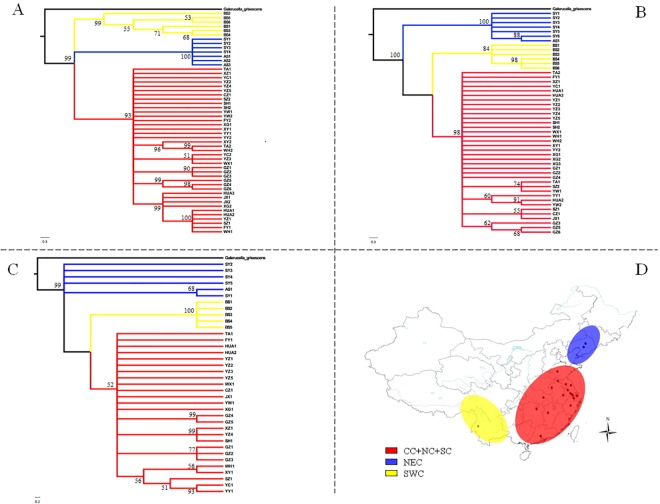
Bayesian phylograms based on sequences obtained from G. birmanica samples.Sequence data are shown for COI (A), COII (B); and (C) Cytb. (D) Geographical distribution of the three groups. Abbreviations: CC-NC-SC (central-northern-southern China); NEC, northeastern China (NEC), and SWC, southwestern China.